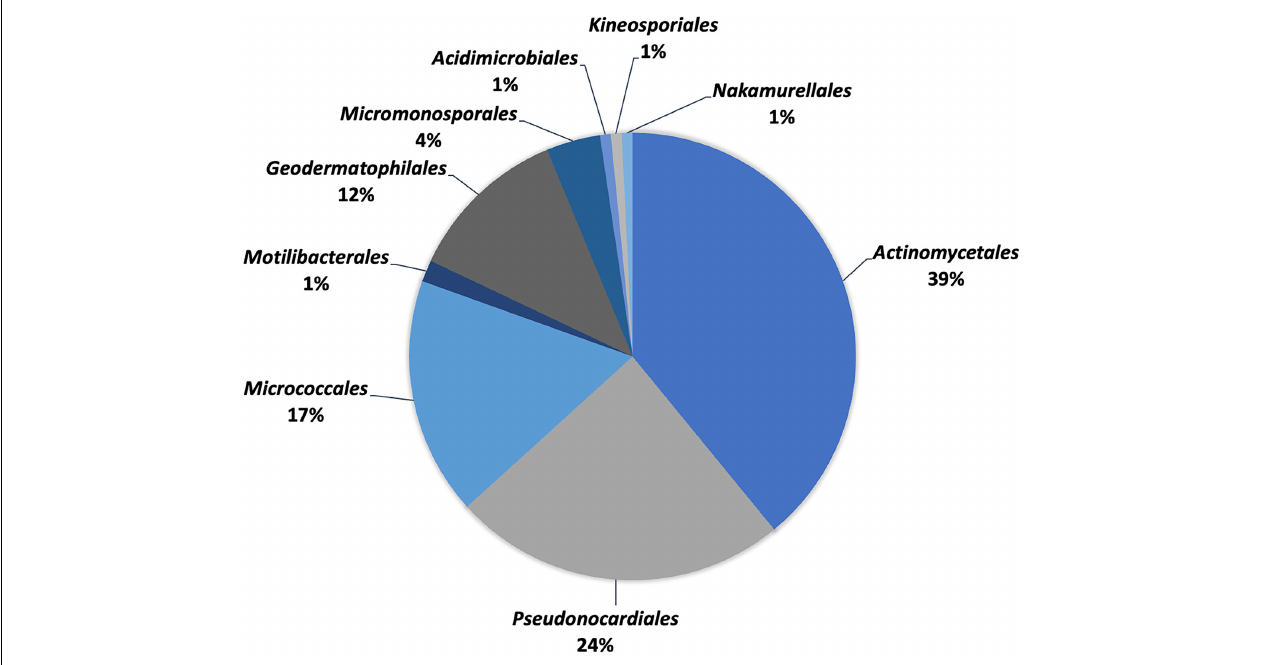
FIGURE 3 | Percentage distribution of different orders of desert